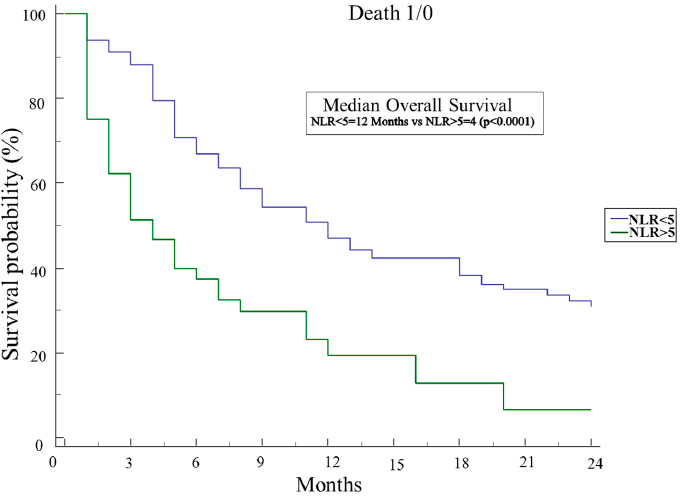
Figure 1. Kaplan–Meier analysis of OS of 206 pancreatic cancer patients with an NLR higher or lower than 5.